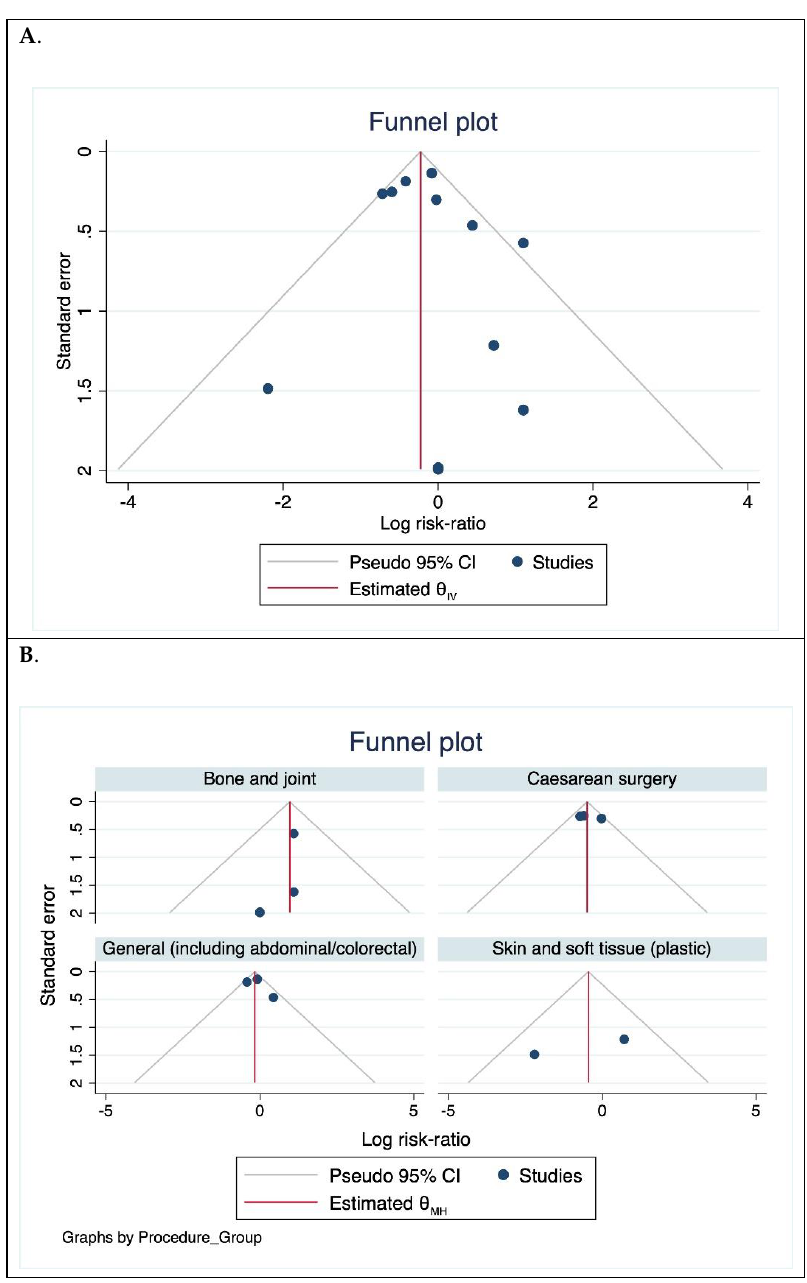
Figure 5 . Funnel plot assessing publication bias. ( A ). For all trials included and ( B ). According to procedure groups.